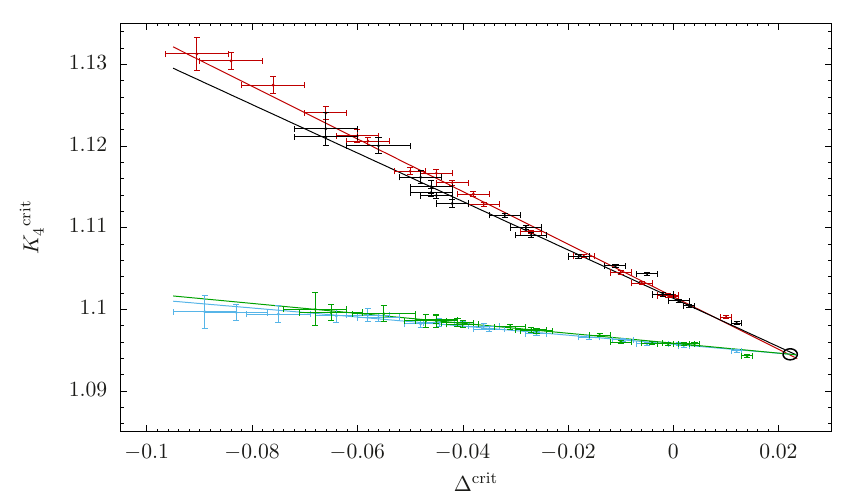
Figure 3 . The pseudo-critical value K crit measured for increasing lattice volume (cid:22) N 41 are going from left to right. Center of the black ellipse corresponds to the estimated position of ((cid:1) crit (